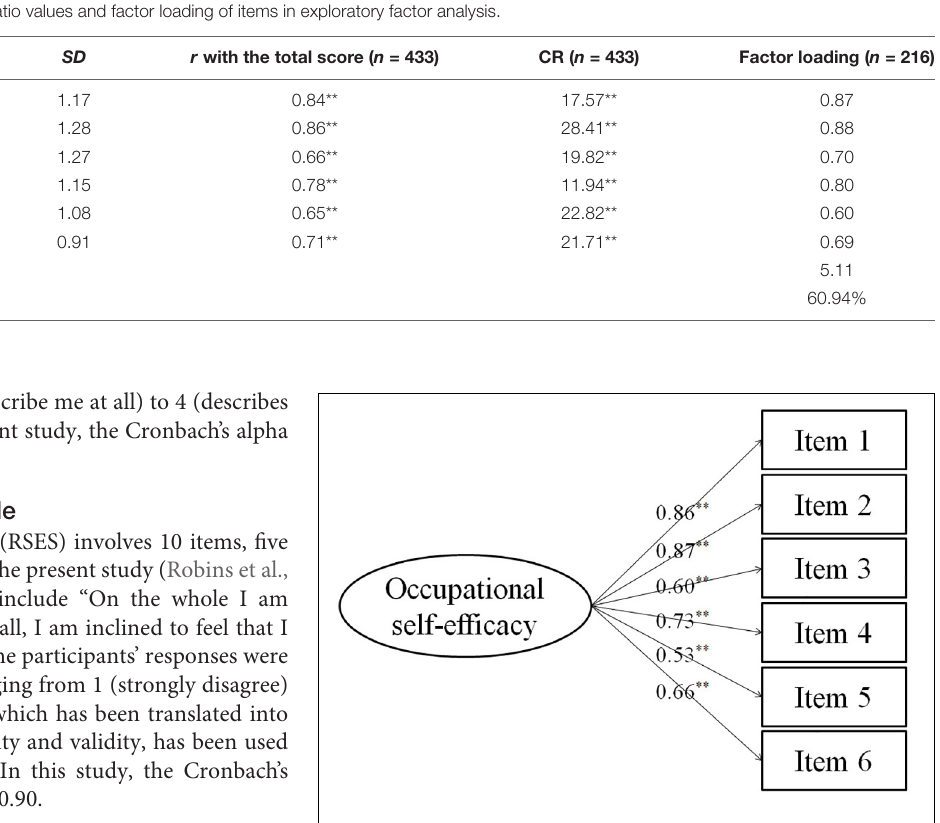
FIGURE 1 | Confirmatory factor analysis. ** P < 0.01. The factor loading was the value from confirmatory factor